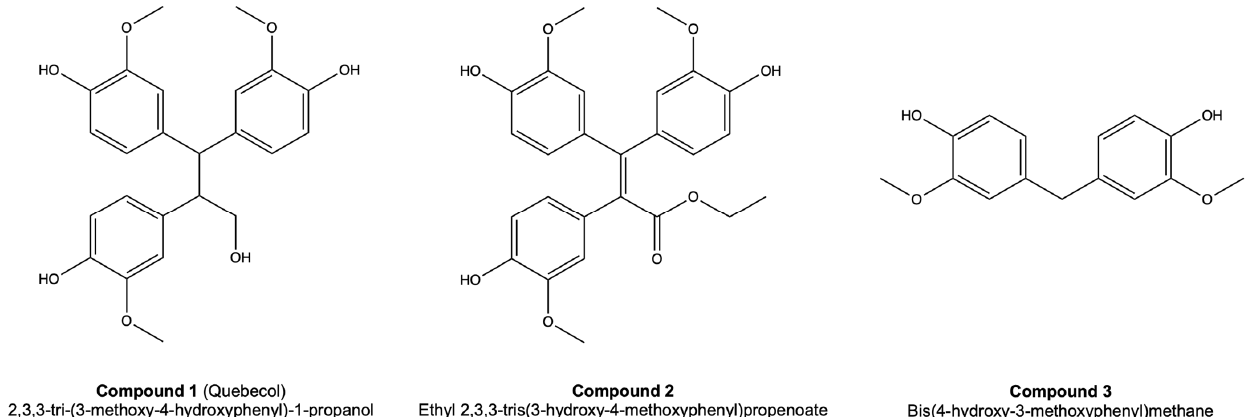
Figure 1. Structure of quebecol (2,3,3-tri-(3-methoxy-4-hydroxy-phenyl)-1-propanol) (compound 1 , CPD1), ethyl 2,3,3-tris(3-hydroxy-4-methoxyphenyl)propenoate (compound 2 , CPD2) and bis(4-hydroxy-3-methoxyphenyl)methane (compound 3 ,